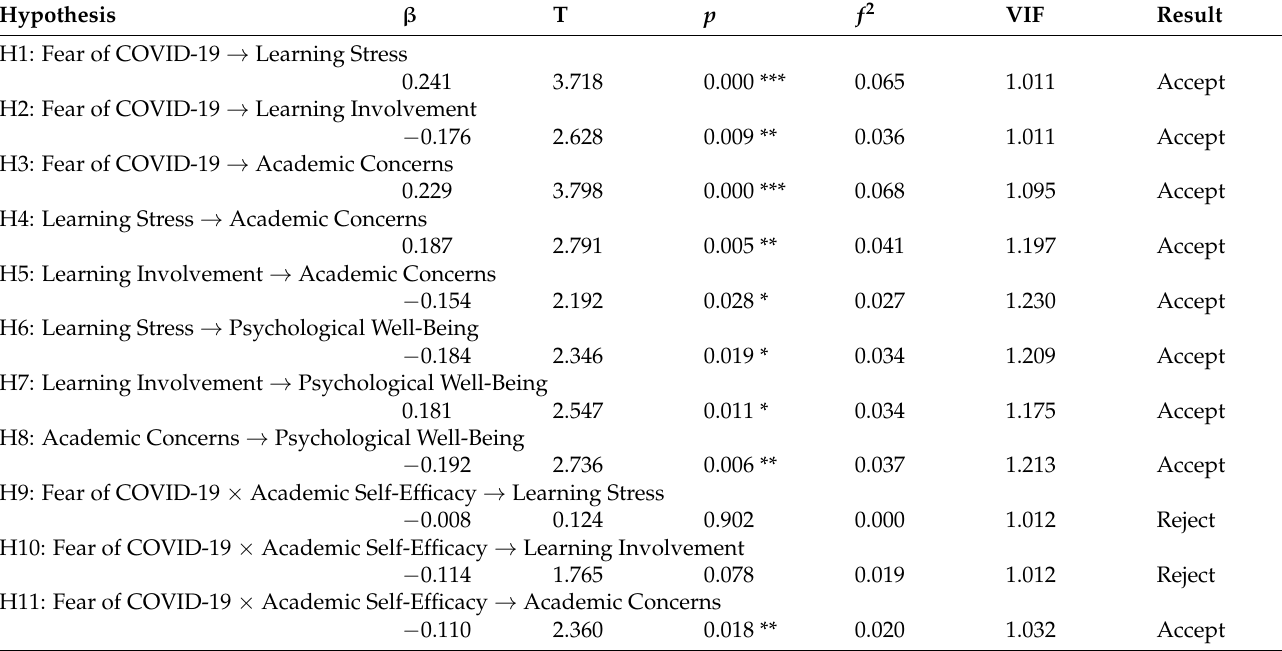
Table 5. Analysis of